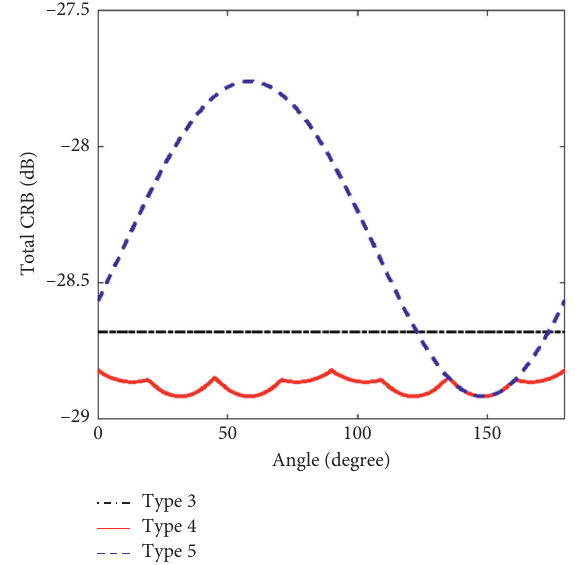
Figure 13: Total CRB of different virtual arrays against different azimuth with fixed